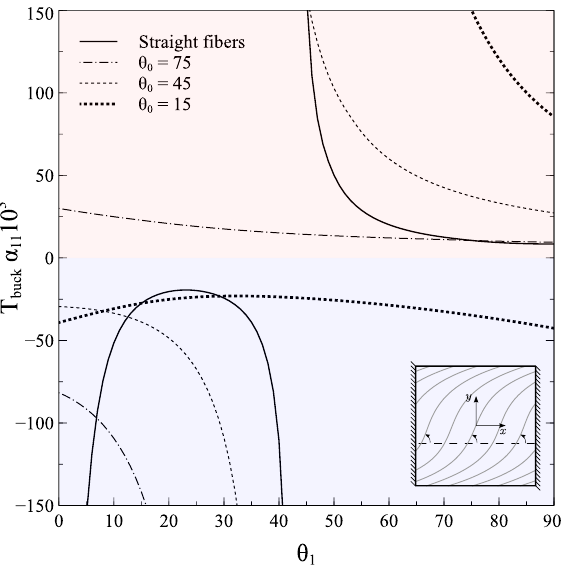
Figure 10. Buckling design charts for different CCCC variable-stiffness configurations, b / h =50. Table 5. Non-dimensional thermal buckling loads 12 subjected to SSSS boundary conditions. Results obtained using LD2 and 14 × 14 trial